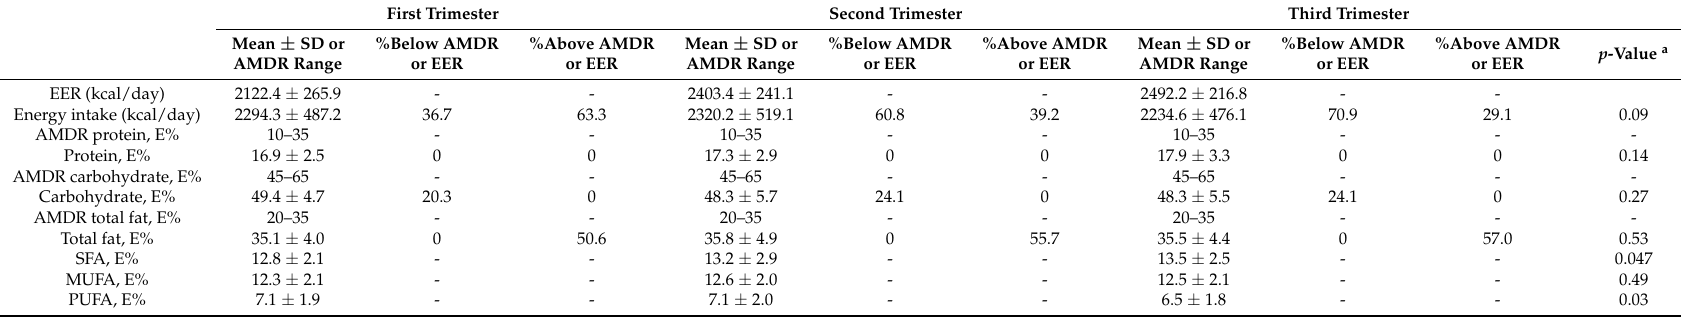
Table 2. Trimester-specific energy intakes and macronutrient intakes as percentage of energy intakes in comparison with dietary reference intakes.